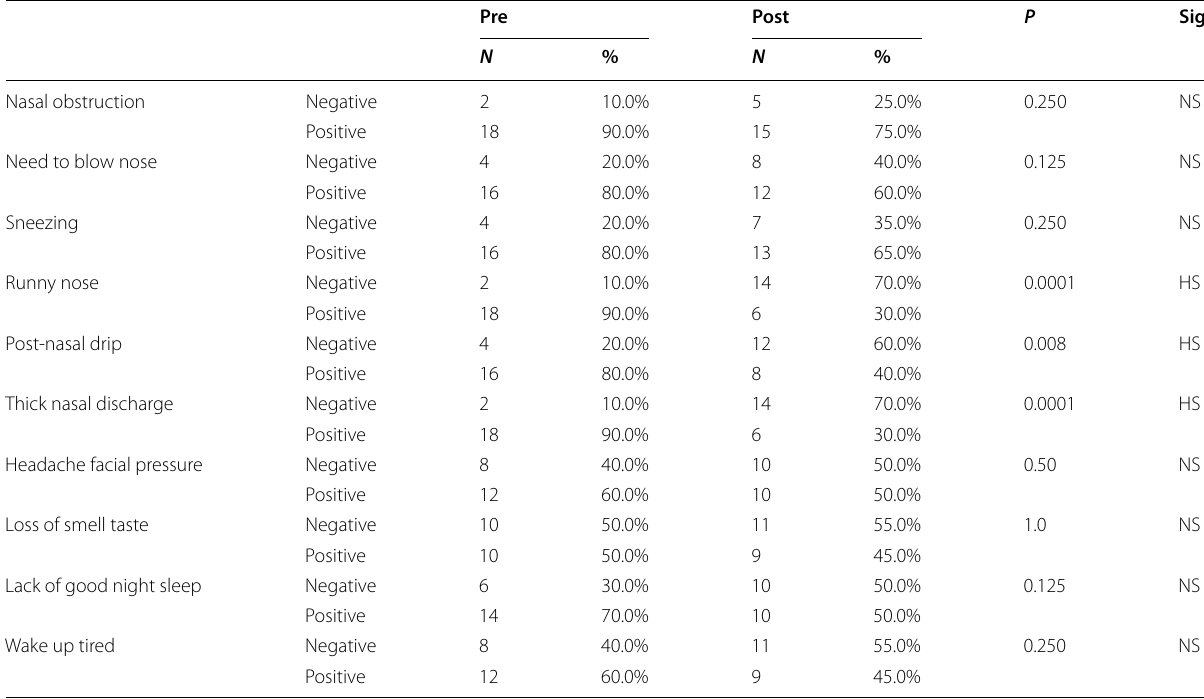
Table 1 Comparison between the pre- and post-SNOT questionnaire of symptoms among allergic group